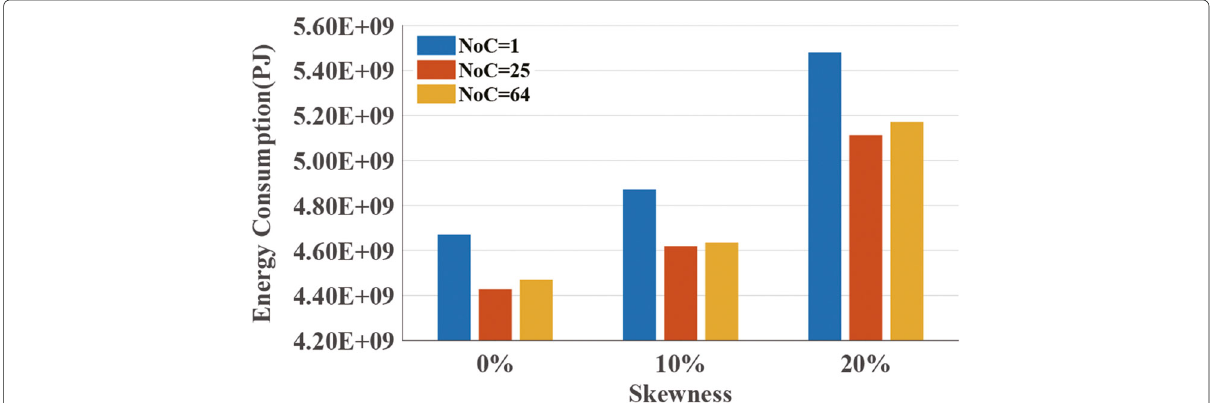
Fig. 6 The effect of skewness and the number of clusters on energy consumption when the cloud is located in the center of the area (50m, 50m). NoC represents the number of clusters in the IoT